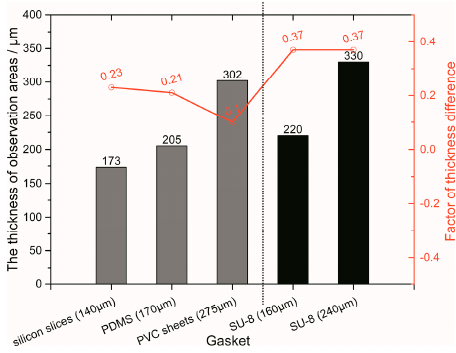
Figure 4. Gasket category and thickness with the corresponding thickness of the PDMS observation area.